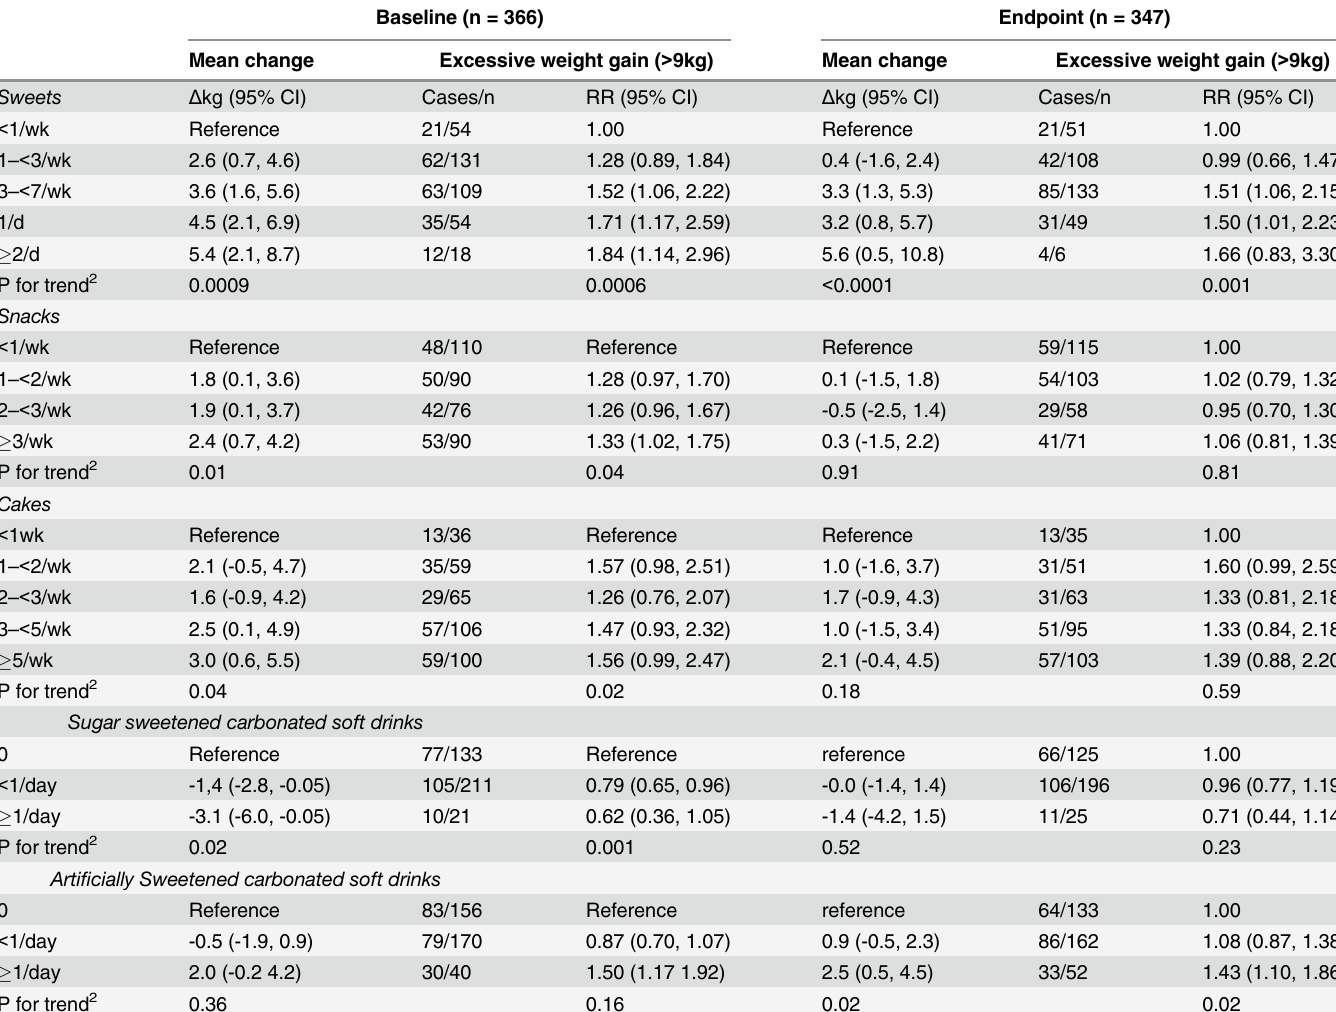
Table 5. Associations 1 between self-reported intake at baseline and endpoint of sweets snacks, cakes and soft drinks with gestational weight gain. Associations for both relative risk (RR) of excessive weight gain ( > 9kg) and mean increase in GWG compared to the reference category ( Δ ) are